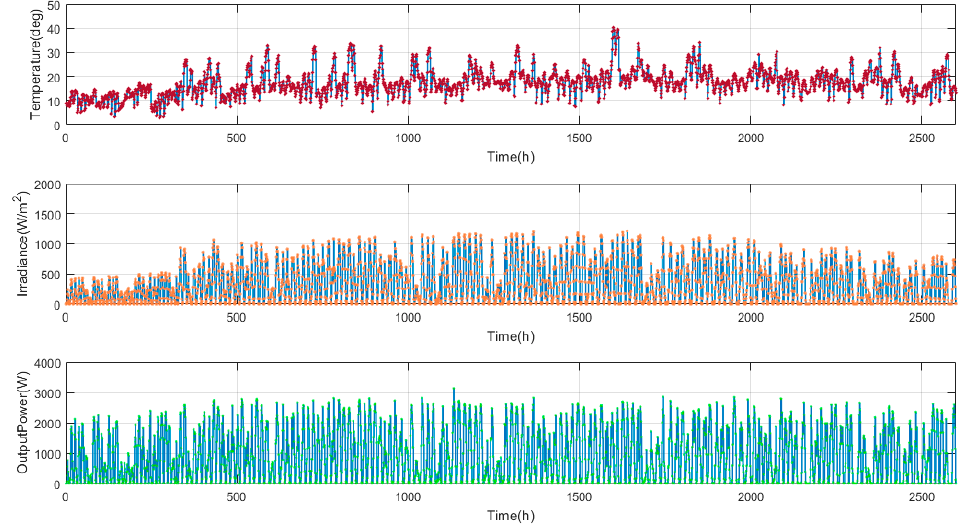
Figure 13. System’s hourly weather data recorded in the local data logger system.